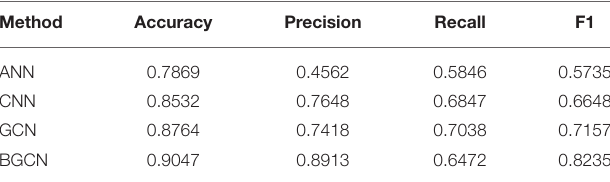
TABLE 1 | Comparison of evaluation metrics with different neural network models. TABLE 2 | Comparison of evaluation metrics with different machine learning